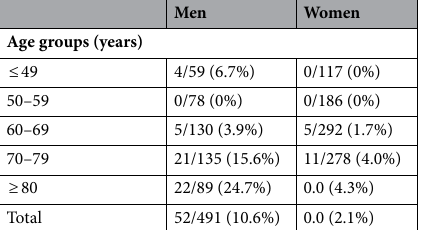
Table 1. Prevalence of PGD by sex and five age groups. The prevalence of PGD tends to increase with age group in both sexes (Cochran-Armitage test; men: p < 0.0001, women: p = 0.0004). PGD pistol grip deformity.